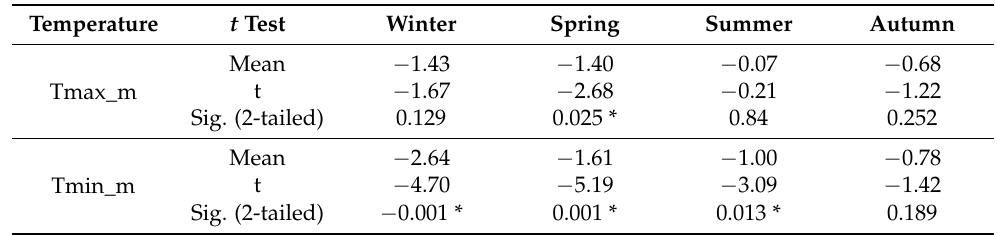
Table 3. The seasonal results of the t test for air temperatures between the wet and dry conditions of the Gavkhouni wetland at Varzaneh station. Temperature t Test Winter Spring Summer Autumn Mean − 1.43 − 1.40 − 0.07 − 0.68 t − 1.67 − 2.68 − 0.21 − 1.22 Tmax_m Sig. (2-tailed) 0.129 0.025 * 0.84 0.252 Mean − 2.64 − 1.61 − 1.00 − 0.78 t − 4.70 − 5.19 − 3.09 − 1.42 Tmin_m Sig. (2-tailed) − 0.001 * 0.001 * 0.013 *